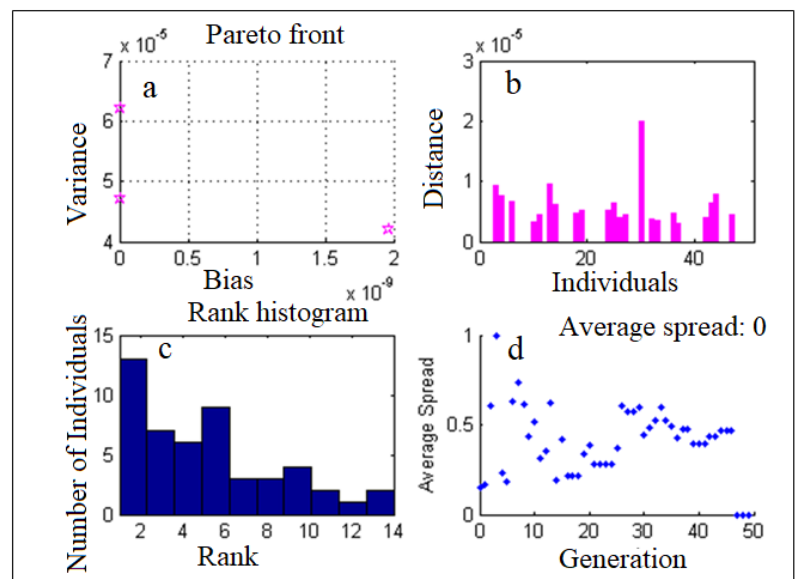
Figure 6. ( a ) Dilemma between the bias and variance objectives. ( b ) Variation of individuals and distance. ( c ) Variation of individuals and corresponding ranking. ( d ) Generation-wise variation of average spreads of